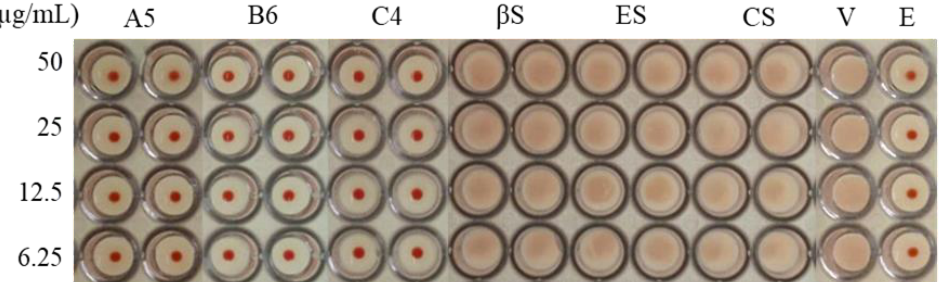
Figure 3. Hemagglutination inhibition assay of some stem bark fractions from E. yucatanensis . Re- sults: full inhibition (red button) or no inhibition (no red button). HI assay of stem bark fractions ( A5, B6 and C4) and analytical standards of β -s itosterol (βS), stigmasterol (ES) and campesterol (CS). B6 and C4) and analytical standards of β -sitosterol ( β S), stigmasterol (ES) and campesterol (CS). Controls: virus + erythrocytes (V) and erythrocytes (E). Controls: virus + erythrocytes (V) and erythrocytes